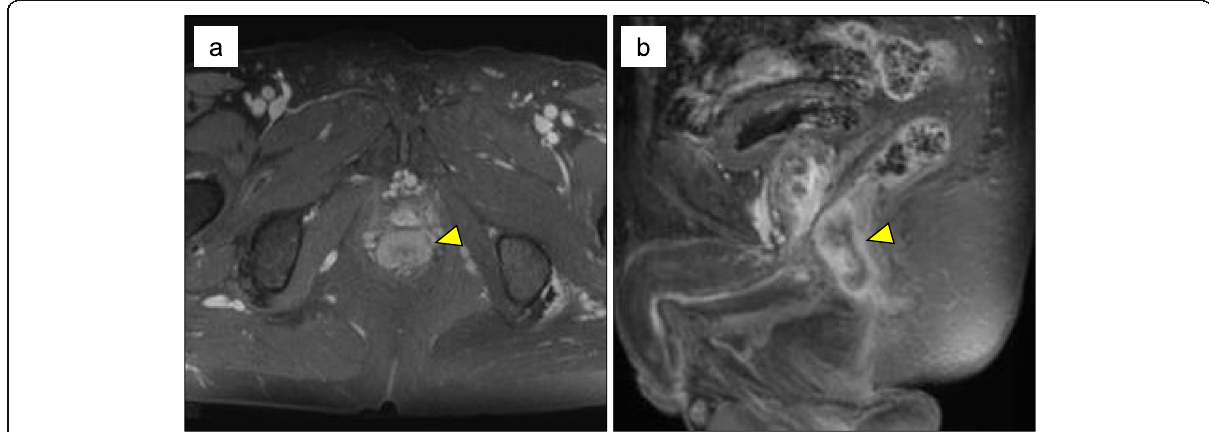
Fig. 3 Pelvic magnetic resonance imaging scan demonstrated the extramural growth of the tumor on the ventral side of the rectum. There was no invasion of the prostate. a Axial image. b Sagittal